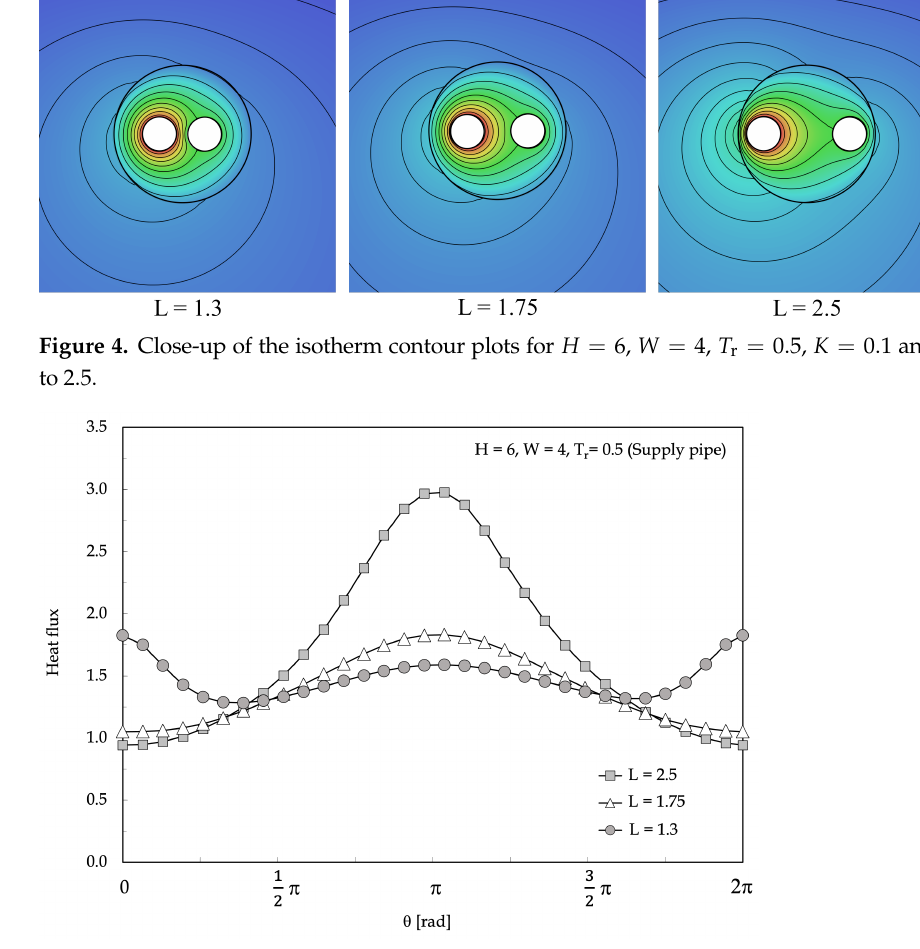
Figure 5. Distributions of the dimensionless local heat loss from the supply pipe q s versus angular coordinate θ using L as a parameter.